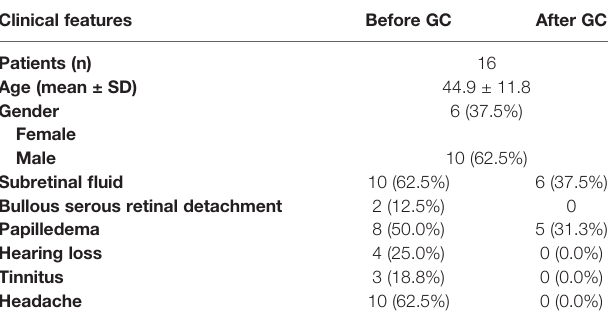
TABLE 2 | Clinical features of VKH patients before and after GC treatment. Clinical